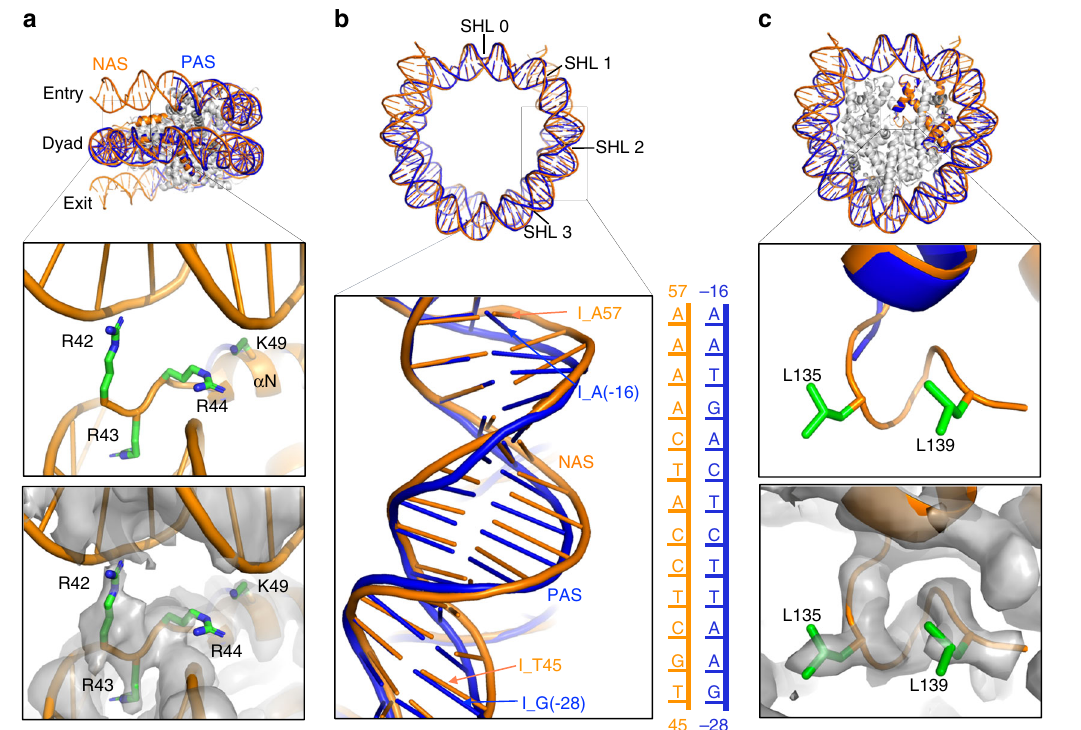
Fig. 3 Comparison of the cryo-EM and crystal structures of the CENP-A NCPs. a Side view (top) of the structures of cryo-EM NCP CENP-A,NAS (orange) and crystal NCP CENP-A, PAS (PDB ID: 3AN2) (blue) aligned using their core histones. Enlarged region (middle) shows the DNA end region. Residues Arg42 and K49 of CENP-A interact with the entry/exit DNA while residue Arg43 of CENP-A inserts into the DNA minor grove and Arg44 interacts with the backbone of the DNA close to the dyad region in the NCP CENP-A, NAS structure. The density map of the same region (bottom), contoured at 2.7 σ . b Top view (top) of the cryo-EM NCP CENP-A, NAS (orange) and crystal NCP CENP-A, PAS (blue) DNA structures aligned using their core histones (not shown). Enlarged region shows the conformational difference of DNA in the two structures at the SHLs 1.7 – 2.5 region. c Top view (top) of the cryo-EM NCP CENP-A, NAS (orange) and crystal NCP CENP-A, PAS (blue) structures aligned using their core histones. Enlarged region (middle) shows the C-terminal tail (LEEGLG) region of